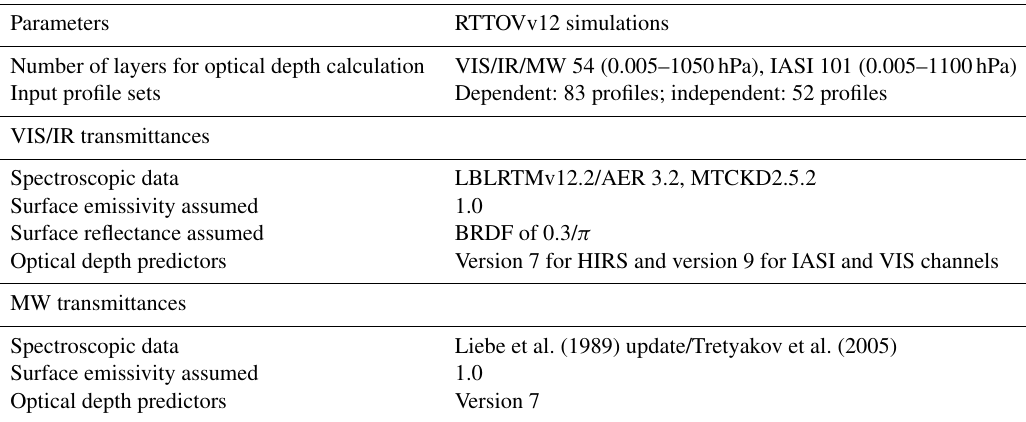
Table 3. The parameters assumed for RTTOVv12.1 vs. line-by-line model